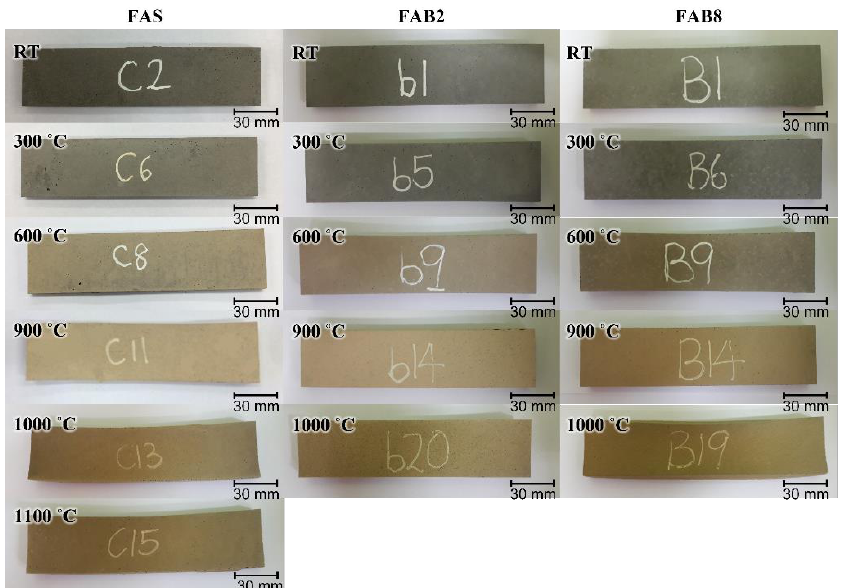
Figure 6. Physical evolution of unheated and heated thin geopolymers at 300 °C, 600 °C, 900 °C, 1000 °C and 1100 °C.